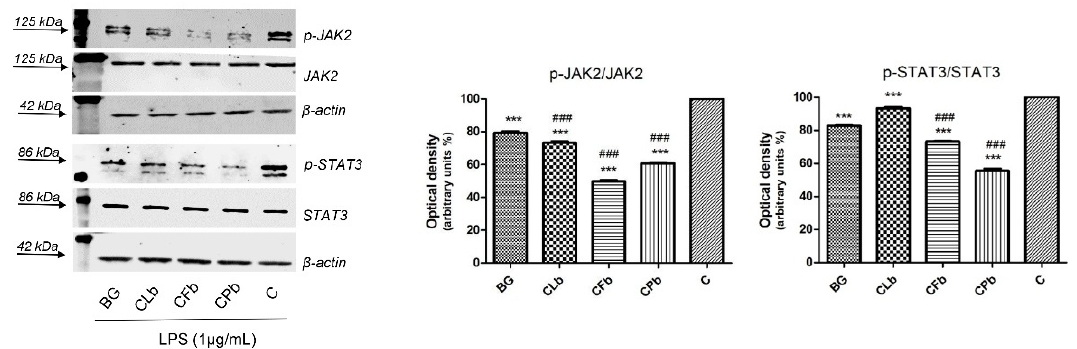
Figure 5 . Cachrys extracts down-regulate p-JAK2 and p-STAT3 protein levels in RAW 264.7 macro- phage cells. The expression of p-JAK2, total-JAK2, p-STAT3 and total-STAT3 was evaluated by Western blot analysis. Cells were lysed after 2 h as indicated in materials and methods. Equal amounts of total cellular extract (30 µg) were analyzed. β -Actin was used as loading control. The graphs show the densitometric analysis: phosphorylated forms were normalized on relative total proteins that have been previously normalized versus β -Actin. CLb: C. libanotis ; CFb: C. ferulacea ; CPb: C. pungens . Formulations were prepared as reported in the Materials and Methods Section 3.2. Significant difference versus control with LPS: *** p < 0.001; significant difference versus